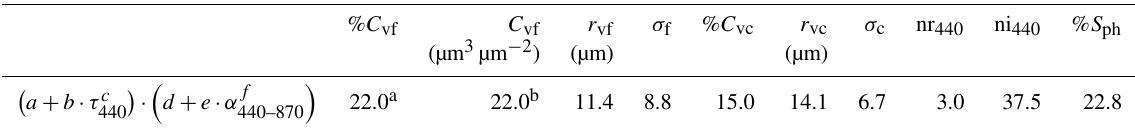
> U % C ( b ; 20% of cases). vf vf